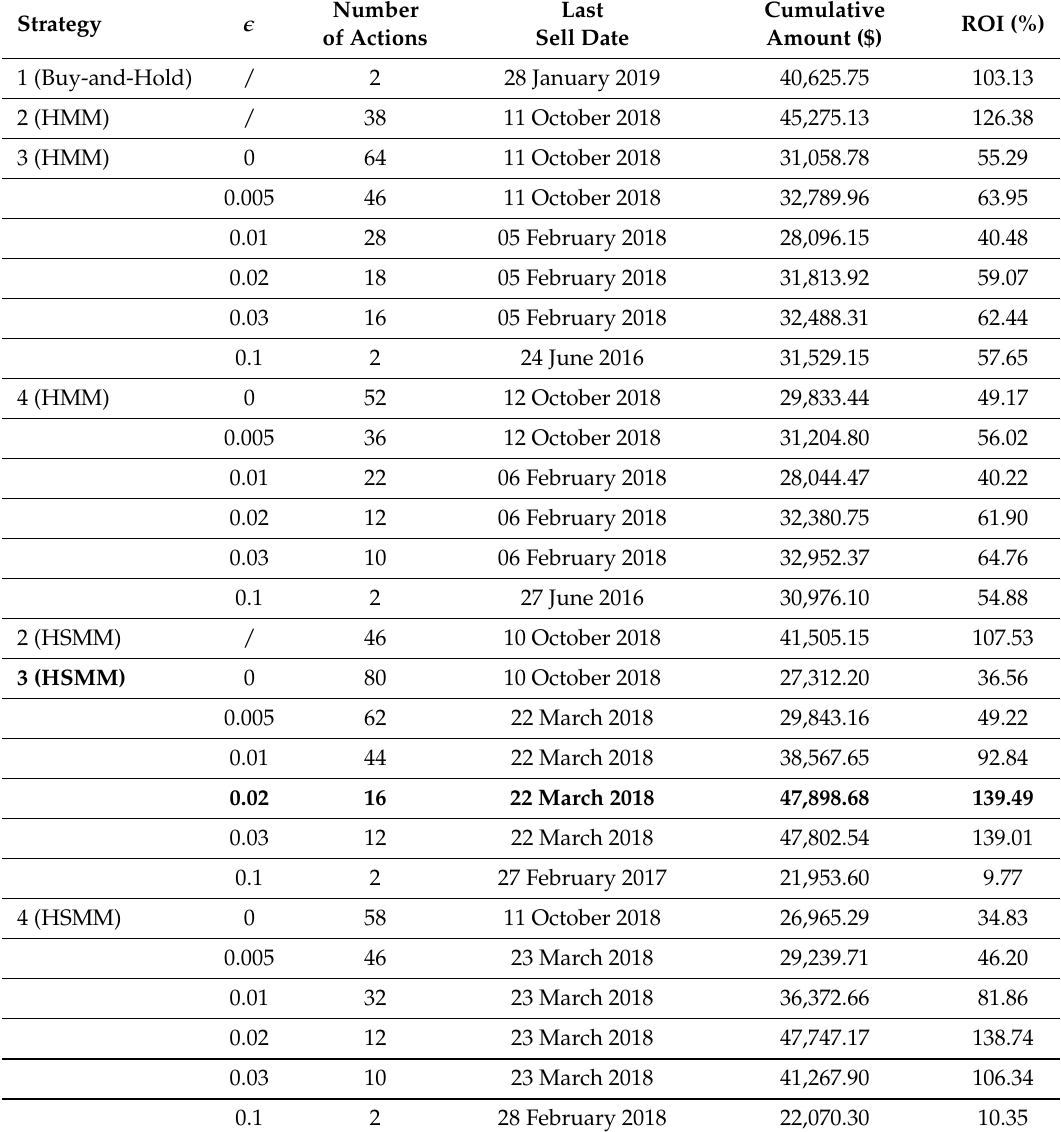
Table 8. Investment metrics for buy-and-hold and HMM- and HSMM-based strategies during